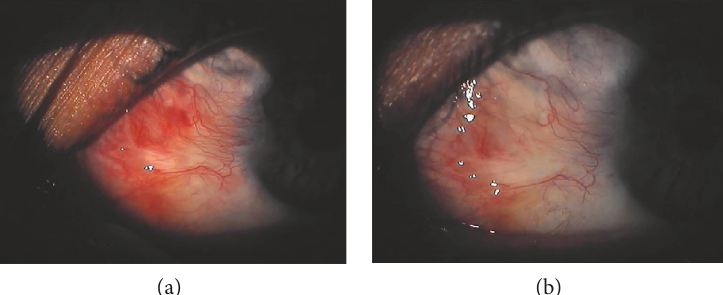
Figure 6: Modi fi cations in lesion vascularization after fi rst subconjunctival bevacizumab injection. (a) Preoperative status and (b) one week after bevacizumab injection. e ff ect rate if compared with the application of mitomycin C.